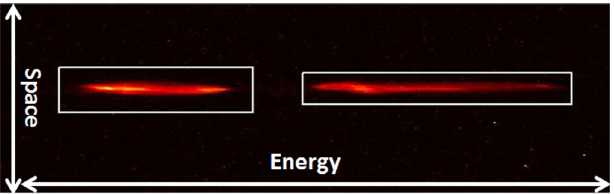
FIG. 3. Emittance measurement in the vertical plane on screen D1.